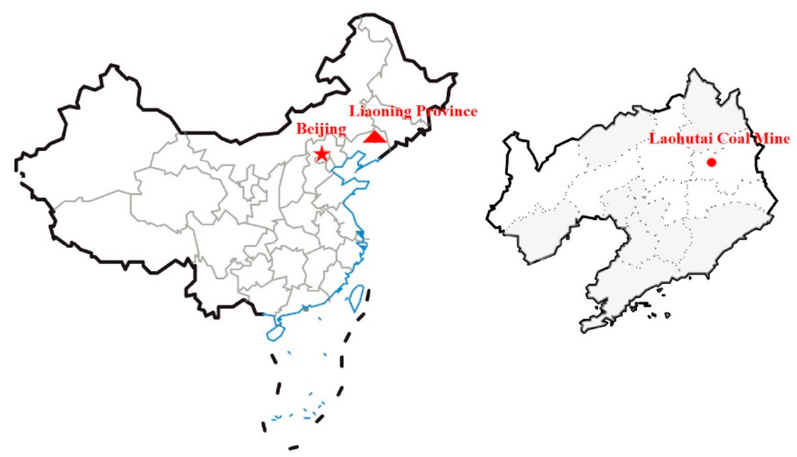
Figure 1. Geographical location of Laohutai Coal Mine.